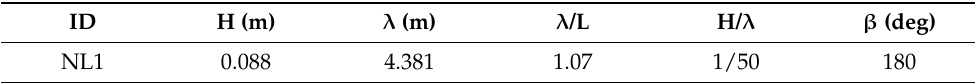
Table 2. Parameter information of NL1